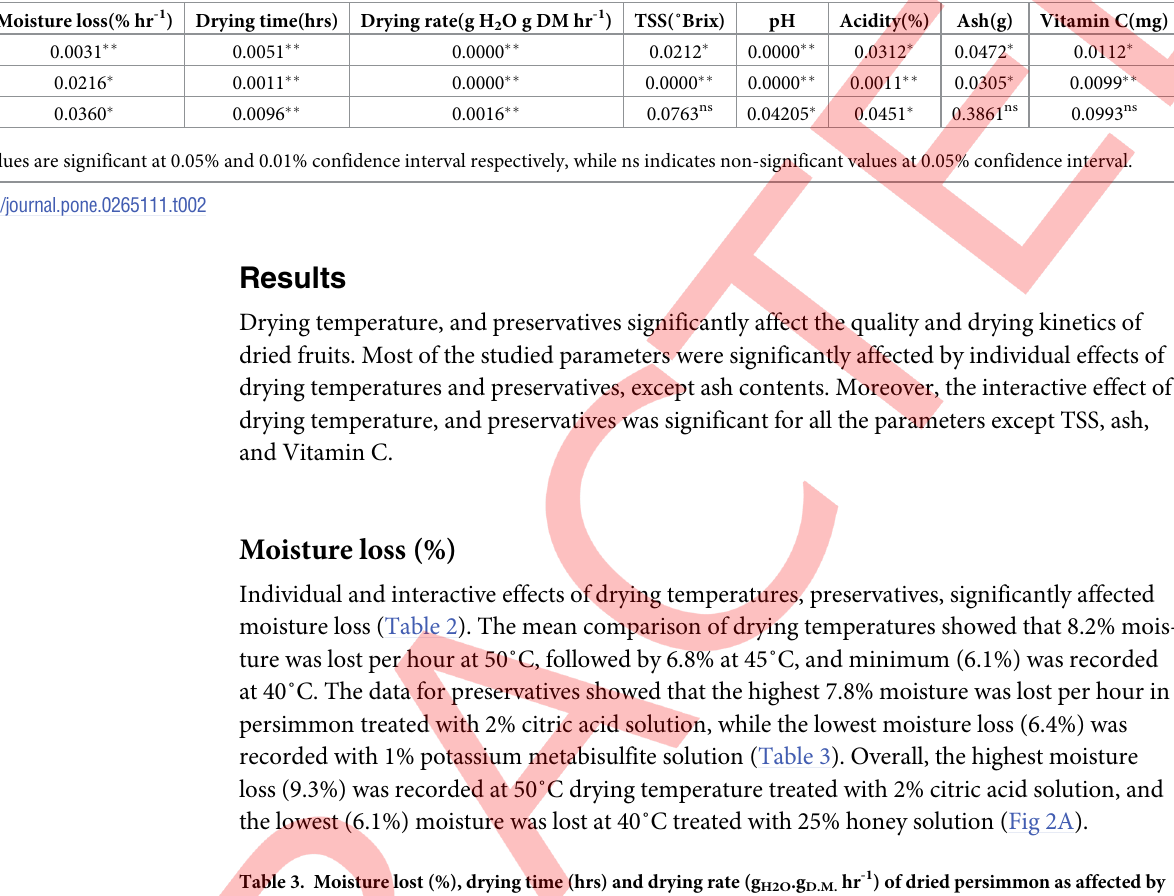
Table 3. Moisture lost (%), drying time (hrs) and drying rate (g H2O .g D.M. hr -1 ) of dried persimmon as affected by drying temperatures and preservatives. Treatments